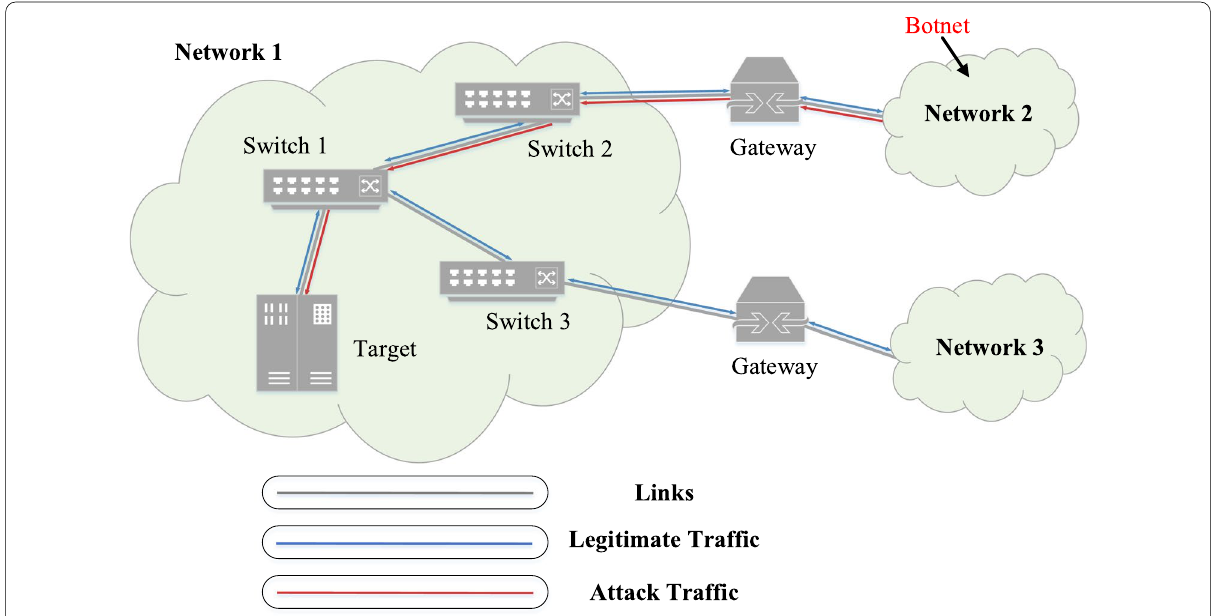
Fig. 3 Testing scenario’s